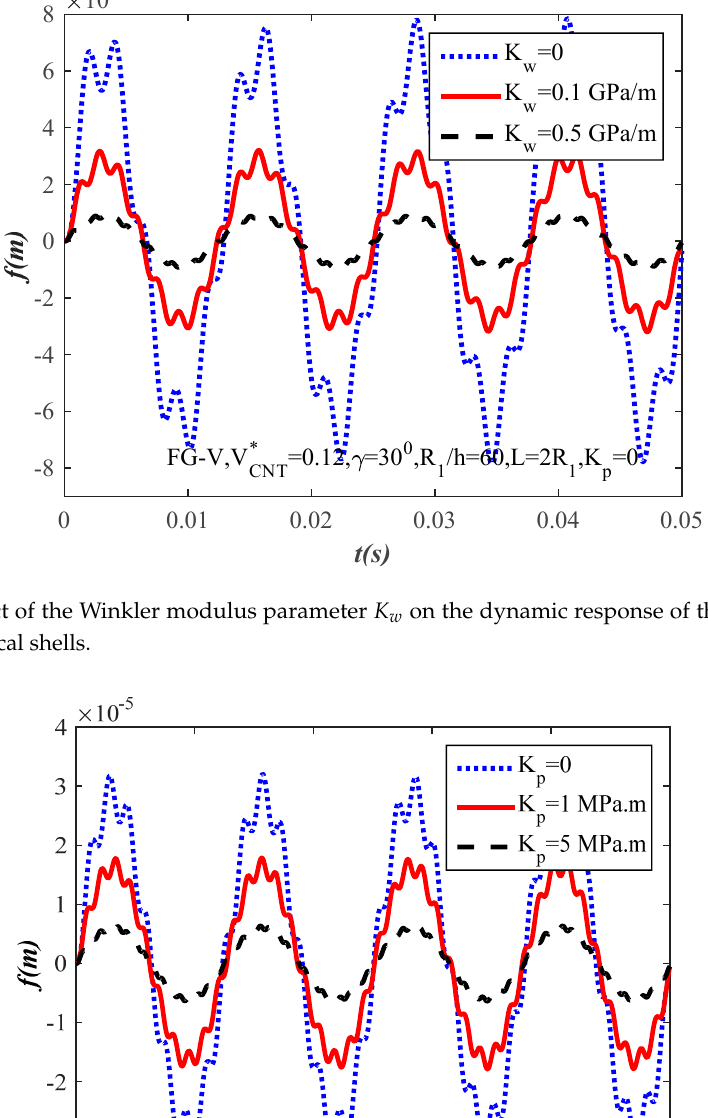
Figure 9. Effect of the Pasternak modulus parameter K p on the dynamic response of the FG-CNTRC truncated conical shells.